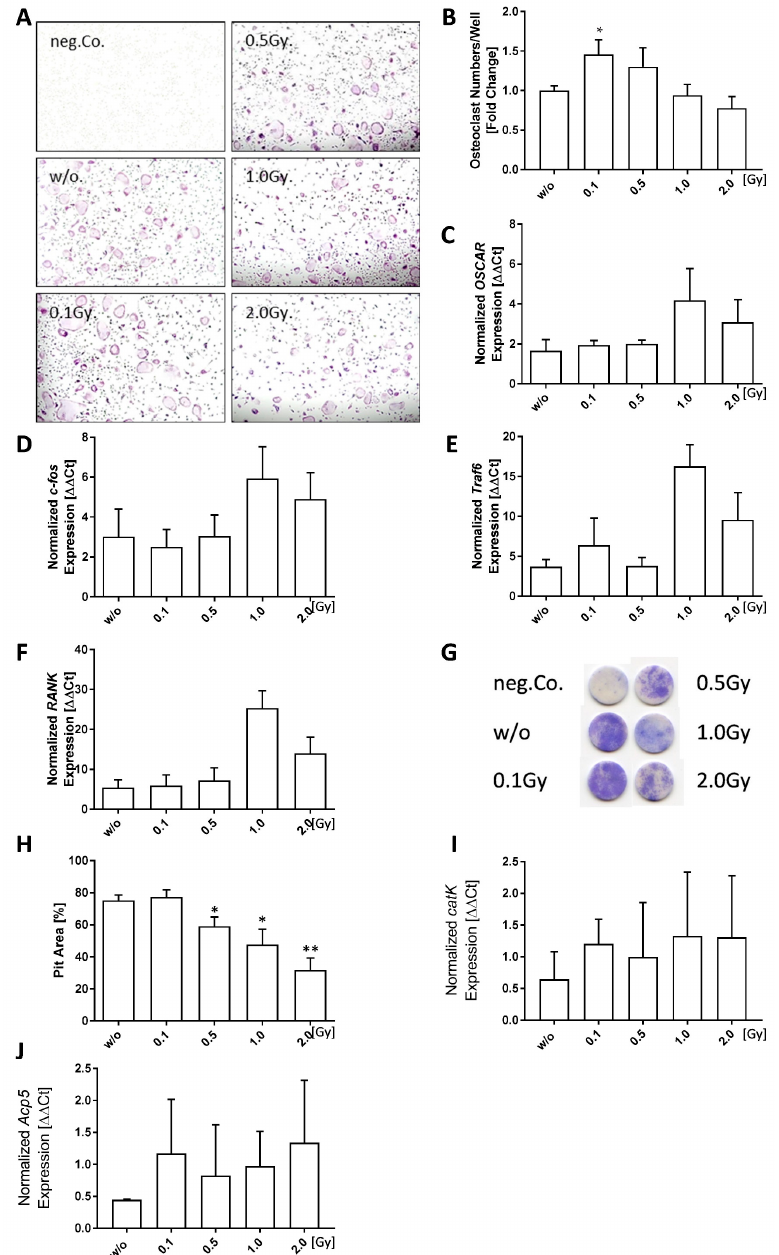
Figure 3. Low doses of ionizing radiation slightly reduces bone resorbing abilities of healthy osteoclasts. Osteoclasts were differentiated from bone-marrow cells from C57Bl/6 animals with 10 ng/mL M-CSF and 50 ng/mL RANK-L over a time period of 6 days ( A , B ). Cells were irradiated with various doses of X-rays 24 h after seeding. Differentiated cells were stained for TRAP ( A ) and counted ( B ), whereas TRAP + cells with at least three nuclei were considered to be osteoclasts. RNA extraction was done using the phenol-chloroform method and subsequent quantitative PCR (qPCR) was performed via SYBR green qPCR analyses ( C – F , I , J ). Normalization was done using the housekeeper genes HPRT and HMBS . Pit formation assay was performed on bone under the same condition as differentiation assays. However, at the end of the incubation period (14 days), bone slices were stained using toluidinblue (TB) ( G ) and pit areas were quantified using ImageJ ( H ). Representative images ( A ) were taken at 5 × magnification. Depicted is the data from four ( A – F , I , J ) or two ( G , H ) independently performed experiments, each performed in triplicates. Data is presented as mean ± SEM and analysed by two-tailed Mann-Whitney-U test in comparison to untreated controls, with the exception of ( B ) which was tested positive for normal distribution and analysed using student’s t -test. (* p < 0.05, ** p <